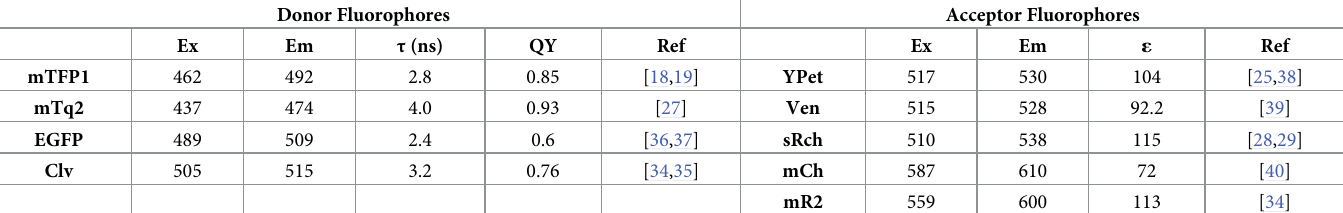
Table 1. Fluorophores used. Ex = peak excitation wavelength (nm), Em = peak emission wavelength (nm), τ = fluorescence lifetime of donor and QY = quantum yield. Extinction Coefficients ( ε ) of acceptors are given in 10E3/M/cm.